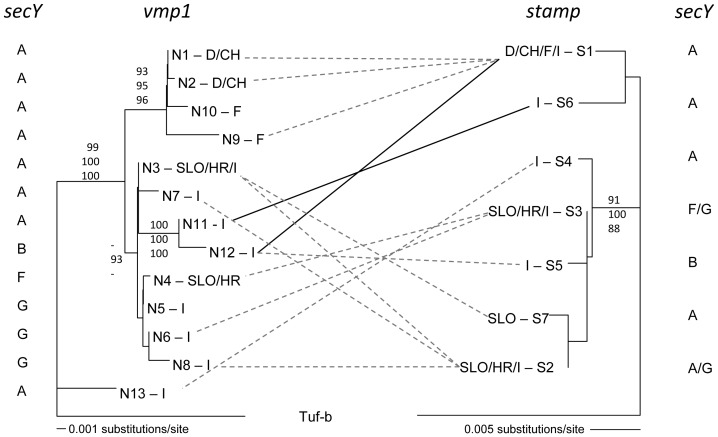
Comparative phylogenetic relationships of stolbur tuf-a vmp1 and stamp genotypes based on isolates sequenced for both genes, and corresponding secY genotypes.Bootstrap scores above 80 are given in following order, NJ, MP and ML. Lines show linked genotypes within isolates: congruent cluster = grey hatched line, incongruent cluster = bold full line. The Italian isolate Rome 7 exhibited the genotypes N11 (vmp1) and s6 (stamp), which belong to different clusters in the two phylogenetic trees (bold full line). Isolates with the vmp1 genotype N12 had stamp genotypes s1 (bold full line) or s5 (hatched line). Note that genotypes in France, Germany and Switzerland north of the Alps cluster together in both trees, and that secY genotypes cluster according to the vmp1 branching pattern. The secY genotype A is the ancestral tuf-a genotype. Geographic abbreviations: F = France, I = Italy, HR = Croatia, SLO = Slovenia, D = Germany, CH = Switzerland. The corresponding SEE-ERANET nomenclature of the tuf-a genotypes is given in Appendix S3.